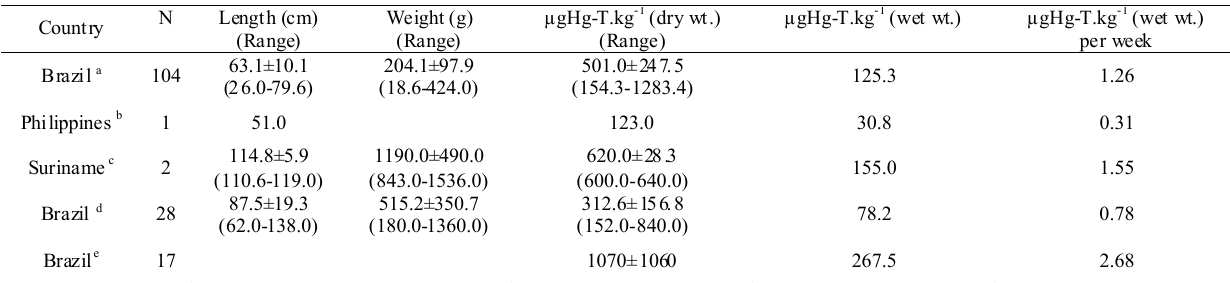
Table 3. Comparisons of (Mean±S.D.) lenght (cm), weight (g), total mercury concentration in the muscle (mgHg-T.kg -1 ) and mean estimates of weekly intake (assuming a regular consumption of 100 g fish.day -1 wet wt.) for Trichiurus lepturus from four different countries/regions based on WHO (1976, 1989). a . Present study; b . Prudente et al ., 1997; c . Mol et al ., 2000; d . Kehrig et al ., 2004; e . Kehrig et al ., 2009.